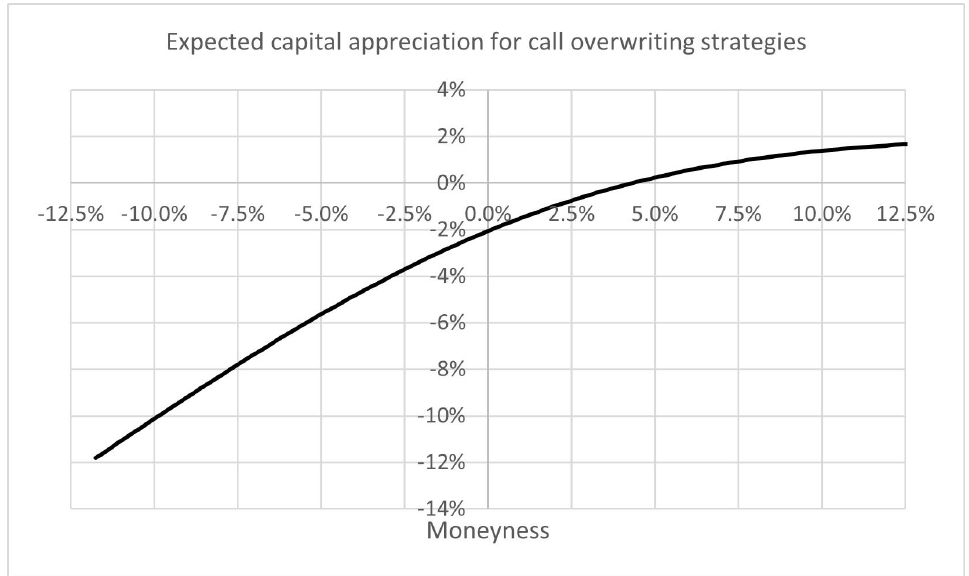
Figure 8. The expected amount of capital appreciation of a portfolio consisting of an underlying asset and a call overwriting strategy for a range of strike prices, assuming the income from the sale of the call option is distributed to the investor. The expected appreciation is negative if the strike price is less than about 4% out-of-the-money. In this case, the investment will eventually become zero